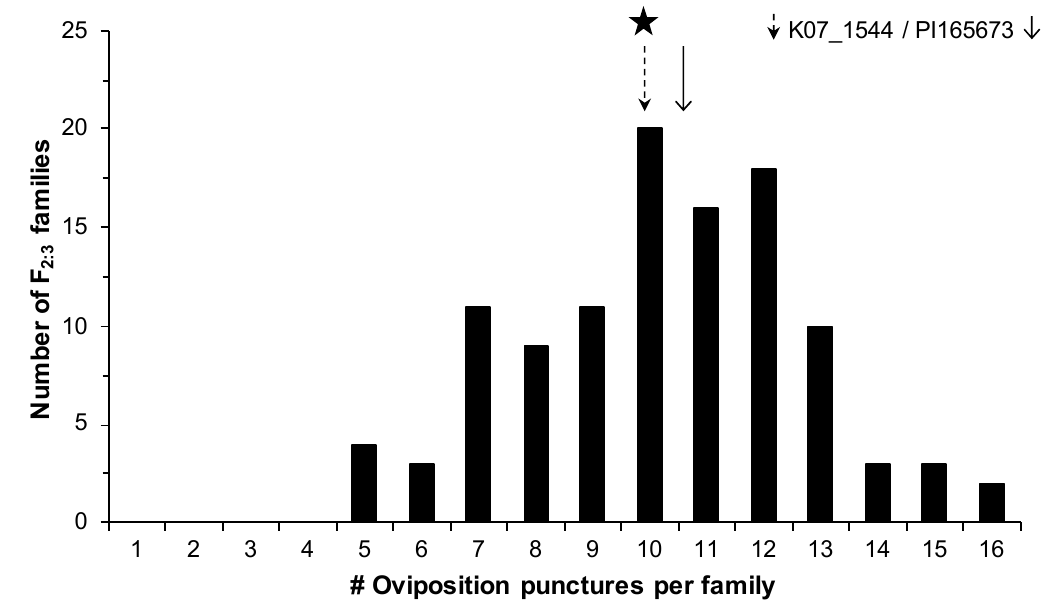
Figure 6. Frequency distribution of number of oviposition punctures per plant in plants from 108 F 2:3 families from the cross K07-1544/PI165673 at 21 d post infestation with Dectes texanus in 2012. Arrows and star indicate parent and F 2:3 population mean, respectively.